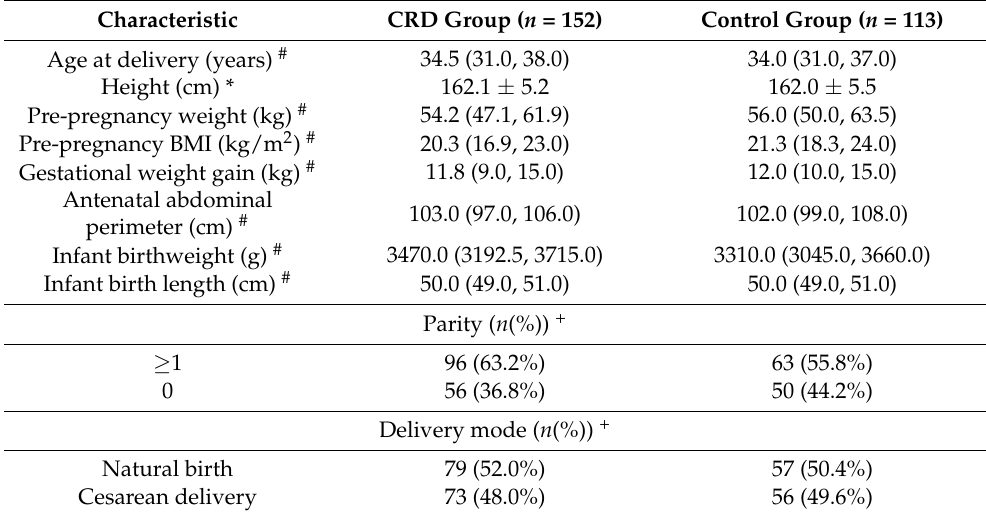
Table 2. Baseline characteristics.